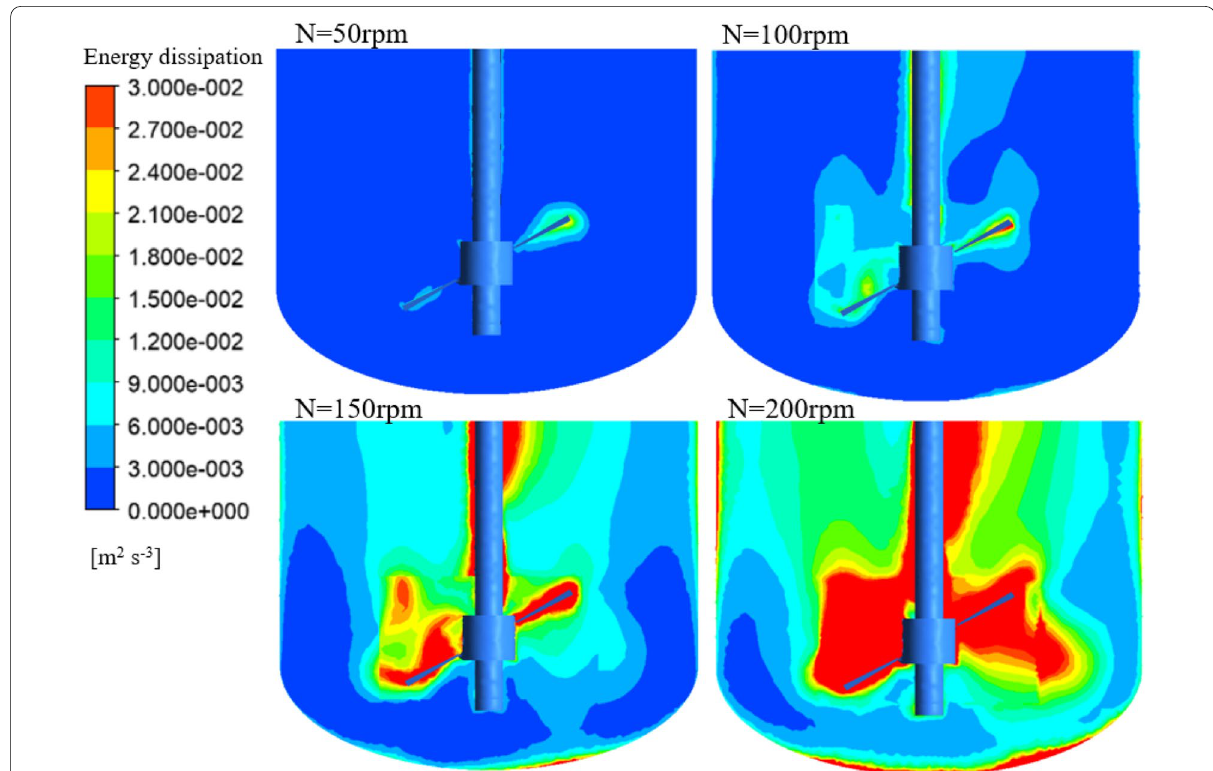
Fig. 2 Distribution of energy dissipation of 5 L bioreactor equipped with EE impeller (impeller diameter/tank diameter 0.45) at different agitation